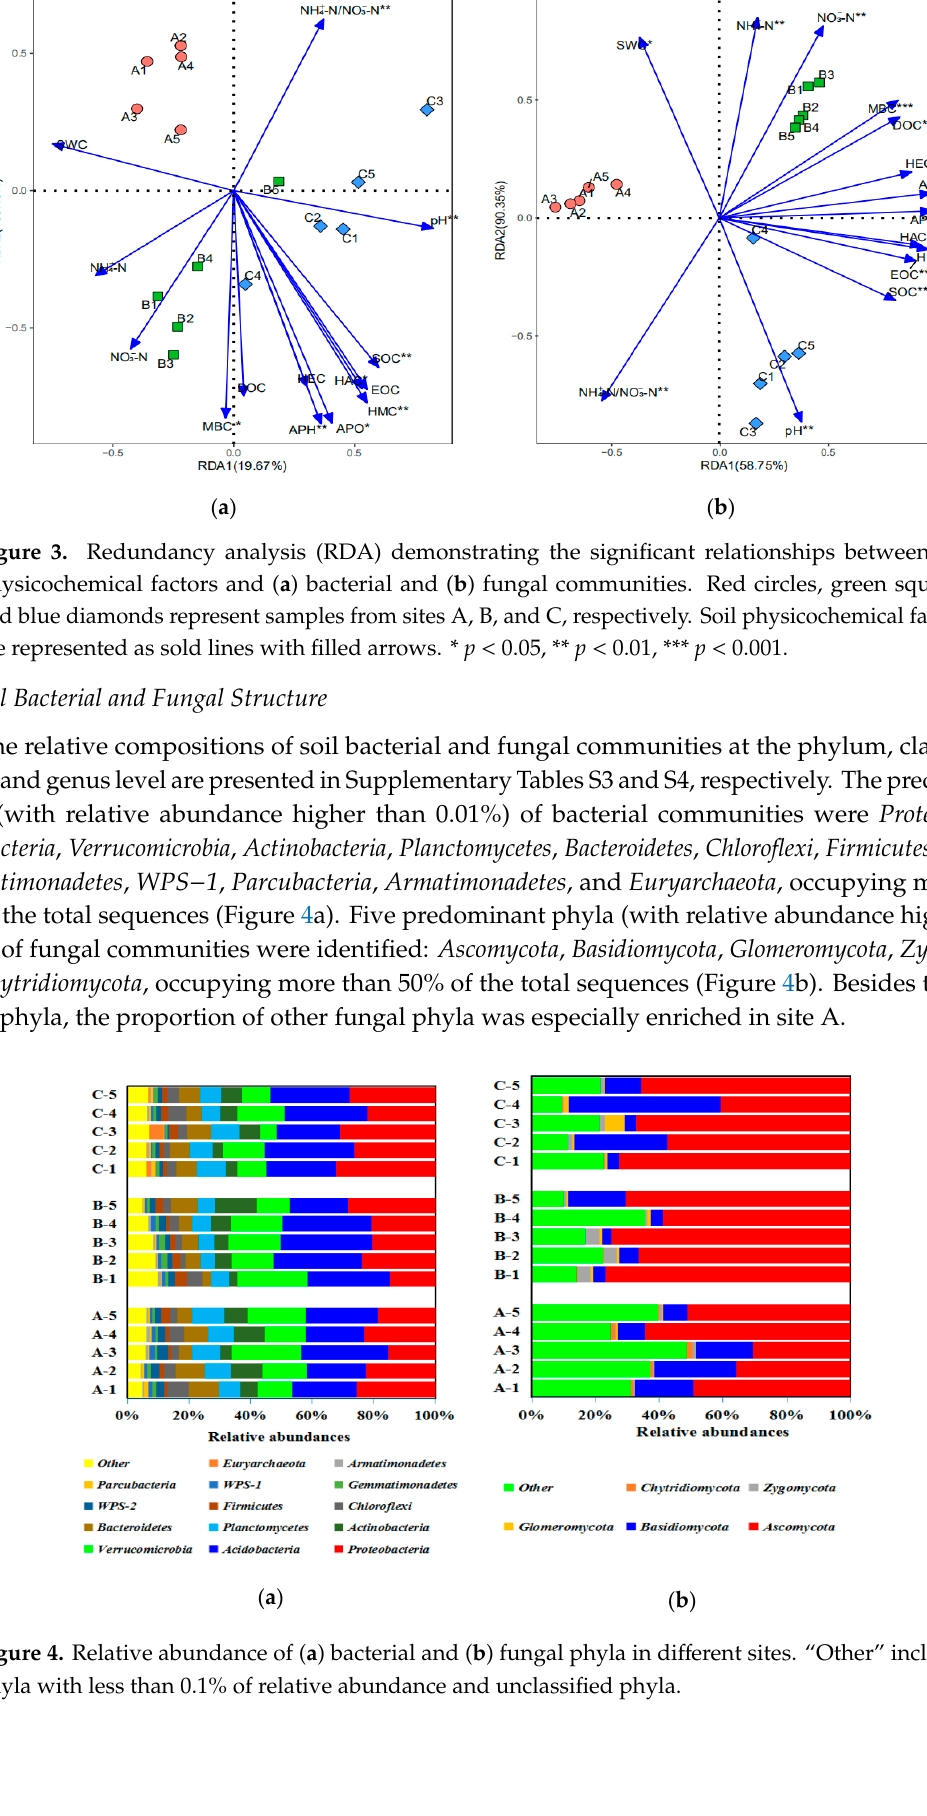
( a ) ( b ) Figure 5. Heatmaps of top 40 genera of soil ( a ) bacterial and ( b ) fungal communities at each site. Relative abundance of soil microbial community from high to low is represented by red, black, and green. 3.4. Differential Operational Taxonomic Units (OTUs) Related to the Occurrence of Chinese Cordyceps